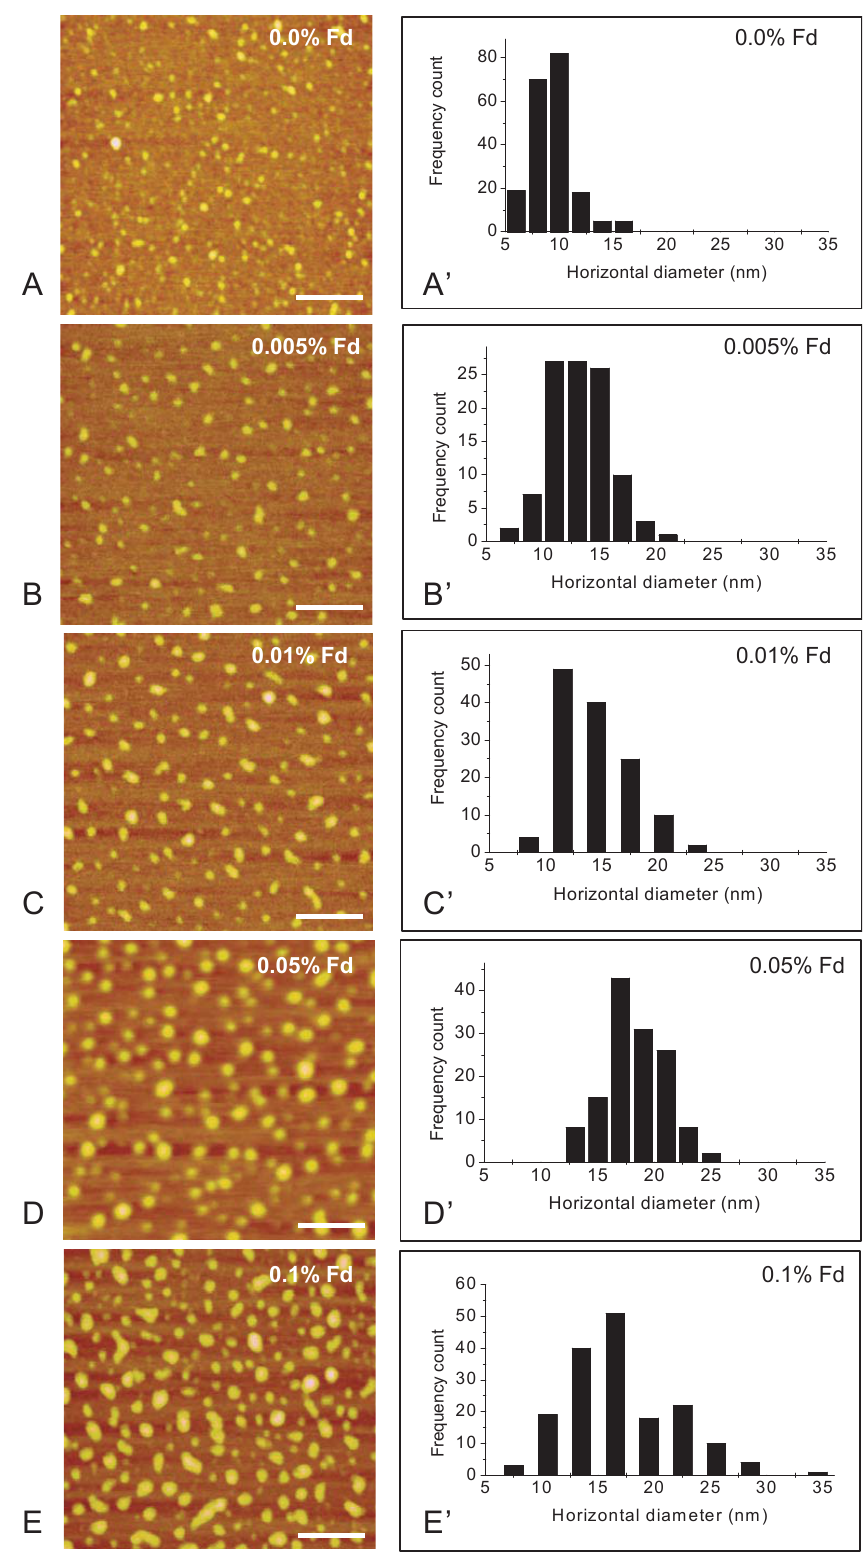
Figure 1. AFM Images of neuronal tau in the presence of formaldehyde at different concentrations. Neuronal tau (20 m M) was incubated in 50 mM phosphate buffer (pH 7.2) containing formaldehyde at different concentrations as indicated at 37 u C over night ( A–E ). Aliquots were taken and diluted to the desired concentration using the phosphate buffer, and the samples were dropped onto mica surfaces and dried in air before observed under the atomic force microscope. The frequency counts of the horizontal diameters (explained in the text) of the protein particles in images A–E were shown in A’–E’ , respectively. The scale bars equal 100 nm.